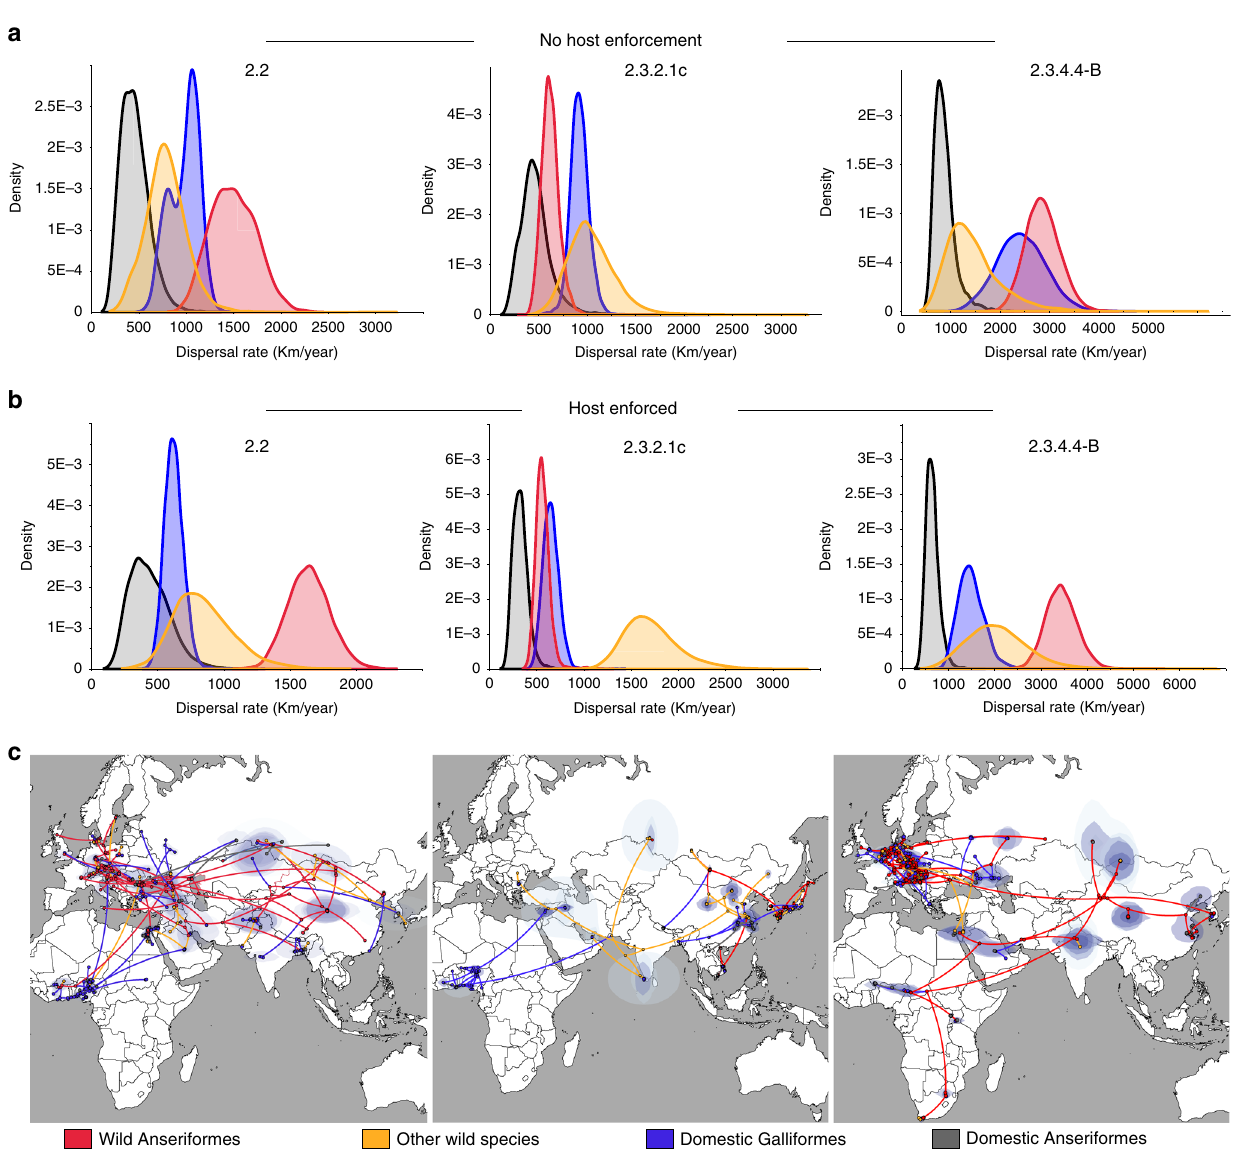
Fig. 6 Contribution of different host types to HPAI H5Nx dissemination. Posterior dispersal rate distributions for each host (red — wild Anseriformes; yellow — other wild species; blue — domestic Galliformes; grey — domestic Anseriformes) obtained by the joint host analyses of the epi-based datasets of the three clades without any host enforcement ( a ) or imposing host species transitions from wild to domestic birds ( b ). c Dispersal patterns obtained from the epi- based datasets are shown for each of the three HPAI H5Nx clades. The lines and dots represent the branches and nodes of the MCC trees and are marked according to the most probable ancestral host trait as described above. Contours represent statistical uncertainty of the estimated locations at the internal nodes (95% credible contours based on kernel density